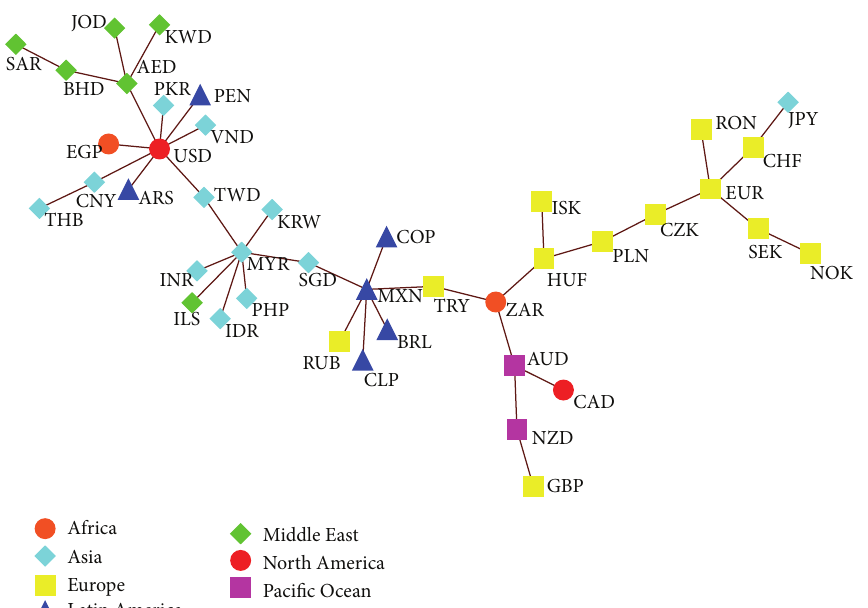
Figure 3: MST of 42 currencies in the international FX market on January 5, 2005, as a representative of the period of before financial crises.